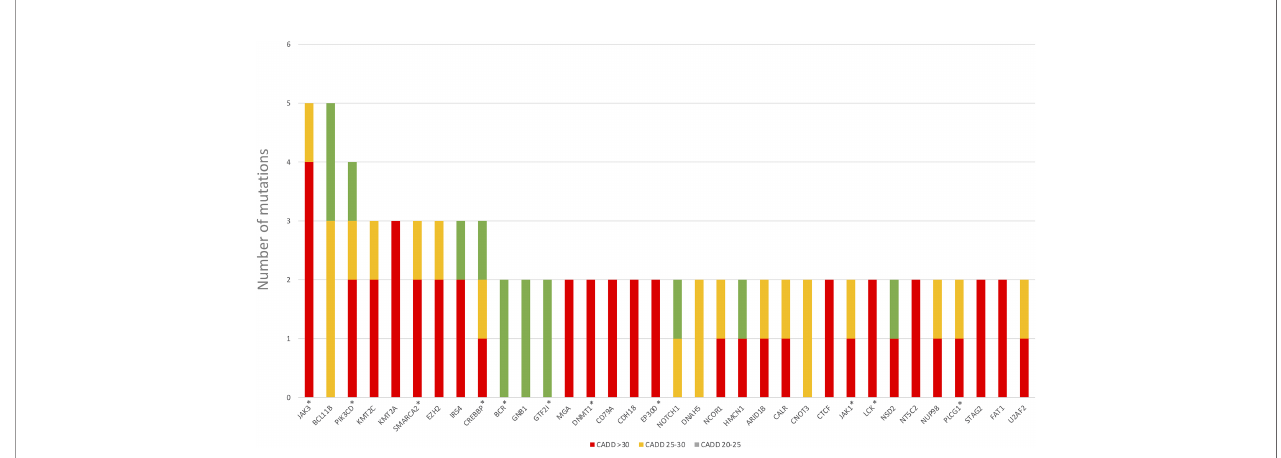
FIGURE 1 | Genes mutated in more than one PTLD sample. *Genes affecting the